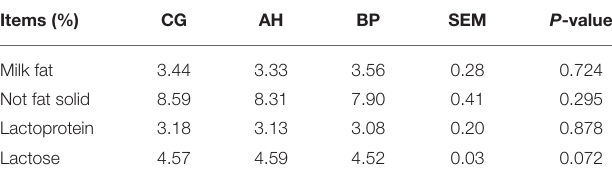
TABLE 6 | Amino acids composition in the milk. Amino acids (g/100g)